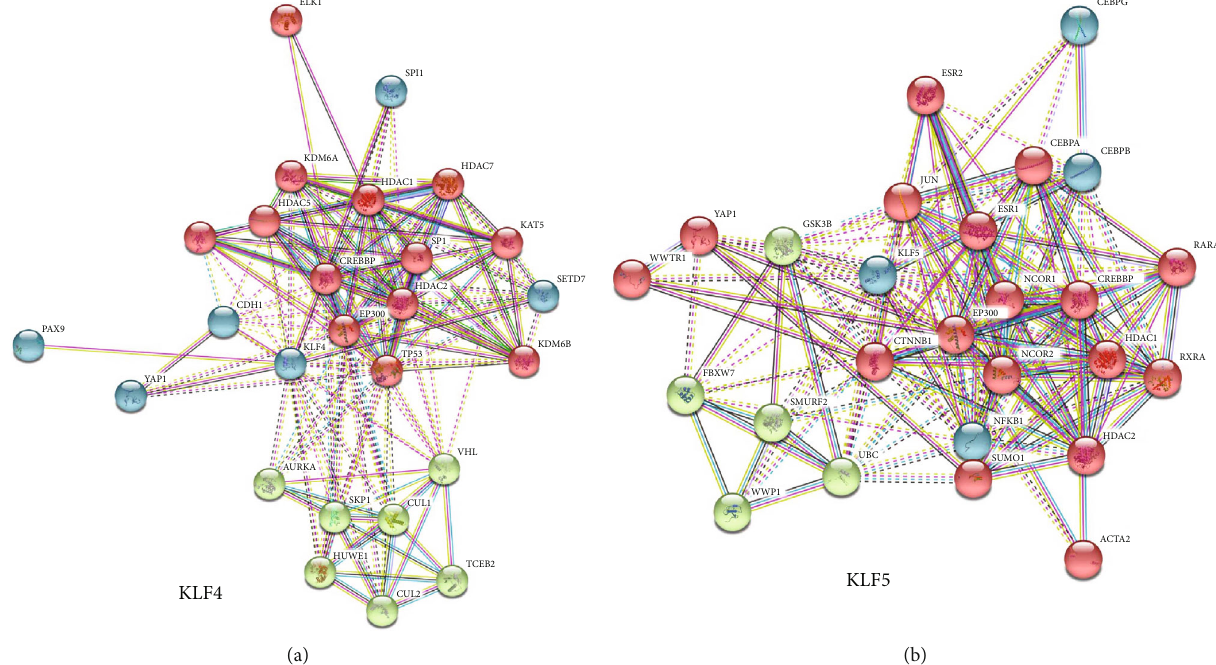
Figure 3: STRING interaction network of KLF4/KLF5 gene interacting proteins. (a) STRING interaction network of interacting proteins of KLF4 gene. (b) STRING interaction network of interacting proteins of KLF5